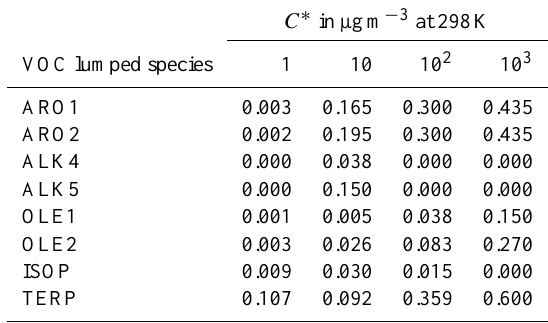
Table 5. Secondary organic aerosol mass yield ∗